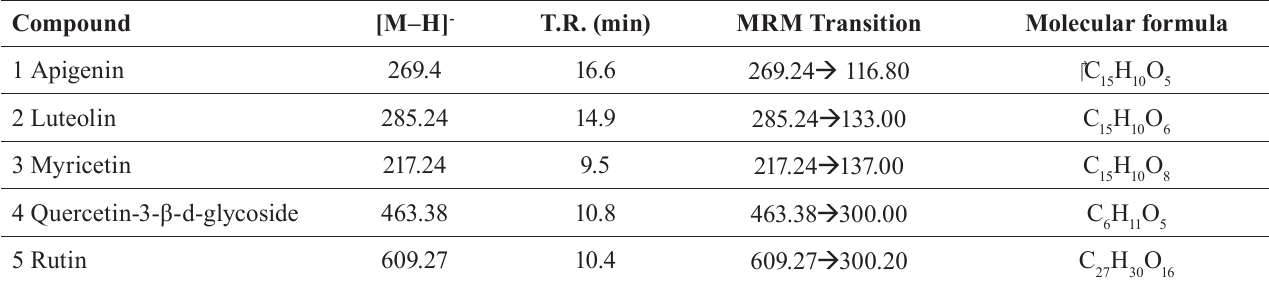
Table III presents the micronucleus frequency (p<0.001) if compared to their respective positive controls in polychromatic erythrocytes (PCEMNs) after pre- treatment with nanostructured and free P . venusta ethanolic extract. The results show 183% reduction + ENU in the frequency of PCEMNs for the LP EPV group (p<0.001) and 114% for the NP + ENU group EPV